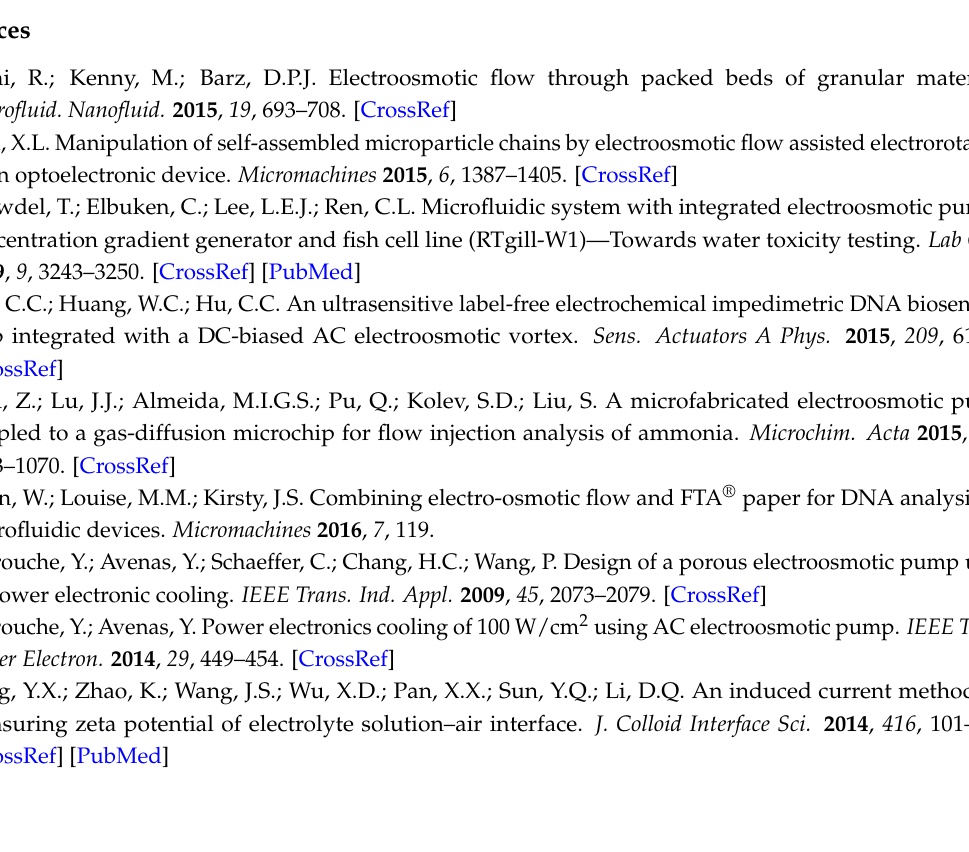
Figure S1: Numerical results of electric field (horizontal plane at middle of pumping channel) of the single-channel pump [27] and the multi-stage channel pump from numerical model; Figure S2: Mean electric field strength in the pumping channel of the single-channel pump [27] and the multi-stage channel pump as a function of applied voltages; Video S1: Fluorescent particle movements in the pumping channels of 20 µ m design pump with 5-stage pumping channels at 50 V; Video S2: Fluorescent particle movements in the pumping channels of 20 µ m design pump with 10-stage pumping channels at 100